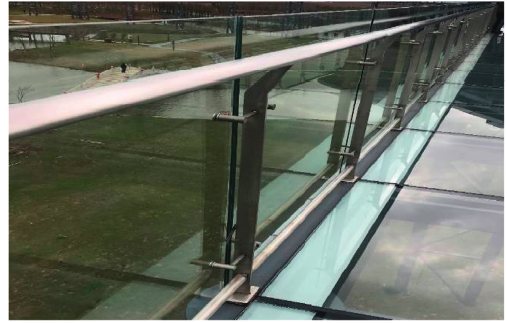
Figure 2: Example of finished